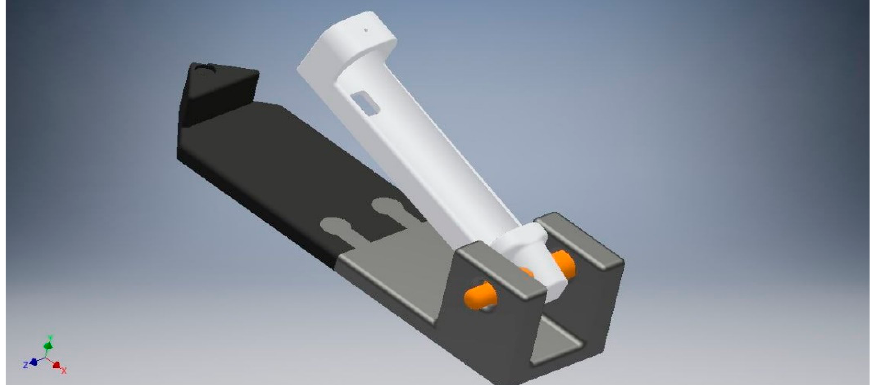
Figure 2. The 3D rendering of the experimental brushing machine.